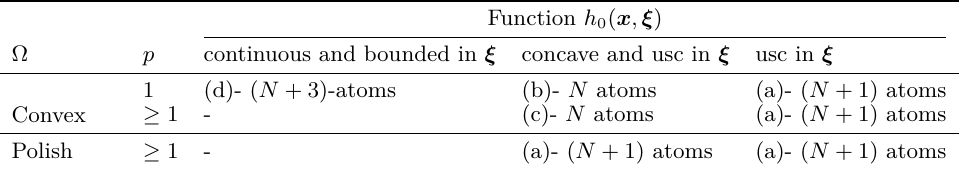
Table 2 Construction of a worst-case probability distribution for optimal transport-based ambiguity sets around an N -atom empirical